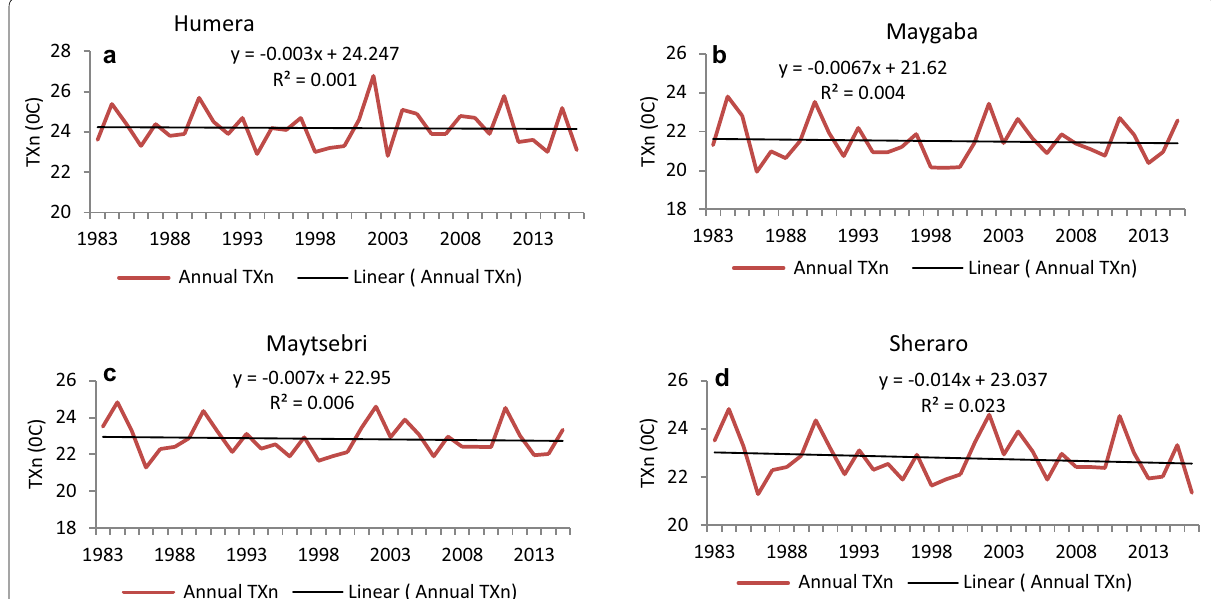
Fig. 3 Trends in annual monthly value of the minimum value of the daily maximum temperature (TXn) at a Humera, b Maygaba, c Maytsebri, d